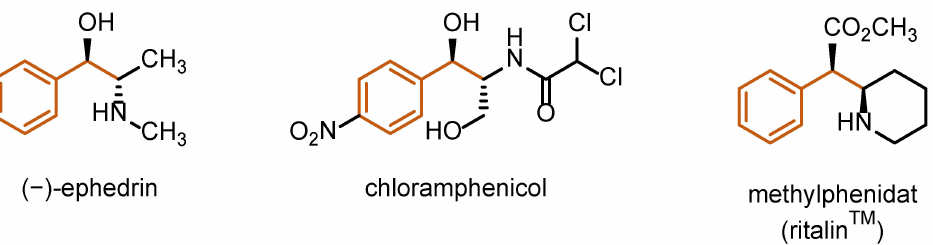
Figure 3. Examples of approved drugs with a 1,2-disubstituted phenylalkane motif